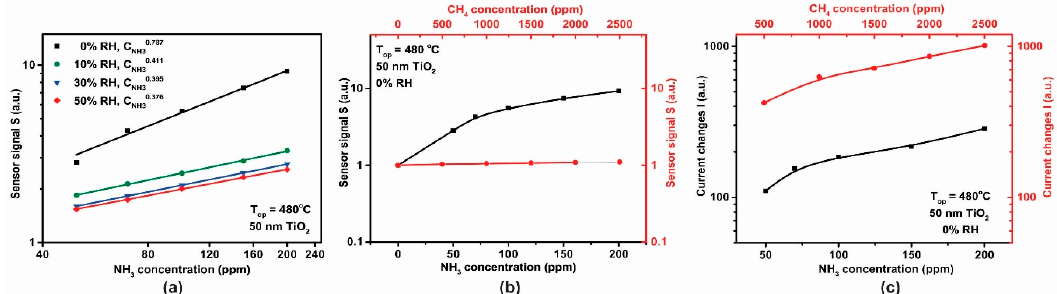
Figure 14. ( a ) Logarithmic plot of sensor signal dependence with respect to the NH 3 concentration, ( b ) sensor signal dependence and ( c ) heater signal dependence with respect to the NH 3 and CH 4 concentrations for the TiO 2 sensor operated under the same testing conditions 0% RH at 480 ◦